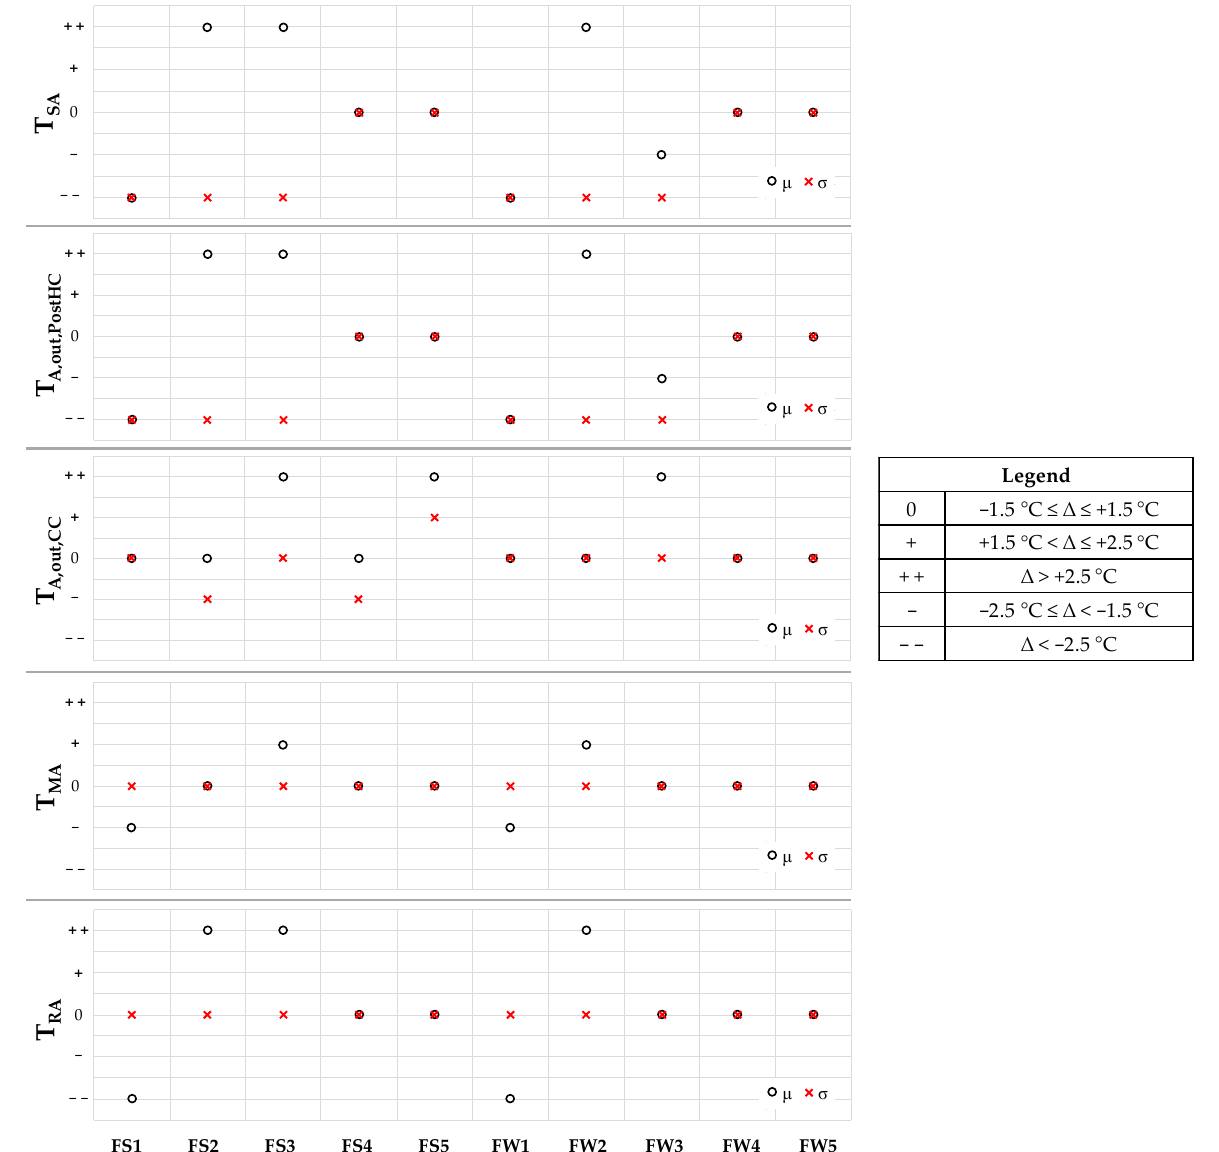
Figure 9. Symptoms’ relevance to the selected faults in terms of air temperature.